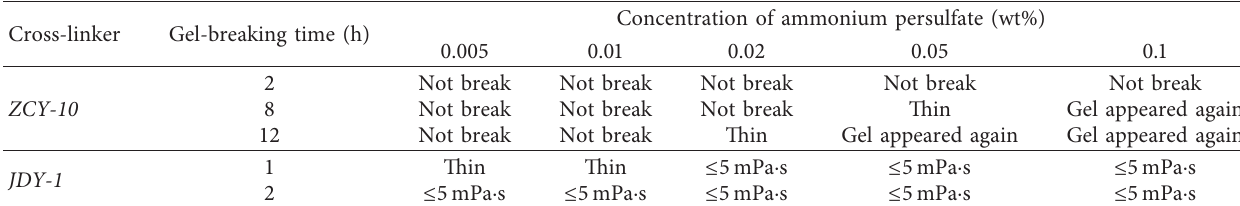
Table 7: Gel-breaker profile of the weighted fracturing fluid at 140 ° C. Cross-linker Gel-breaking time